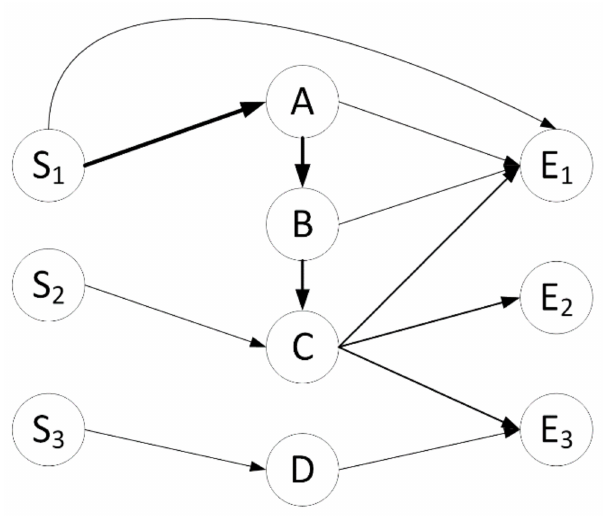
Figure 2. A citation network with the SPC value as